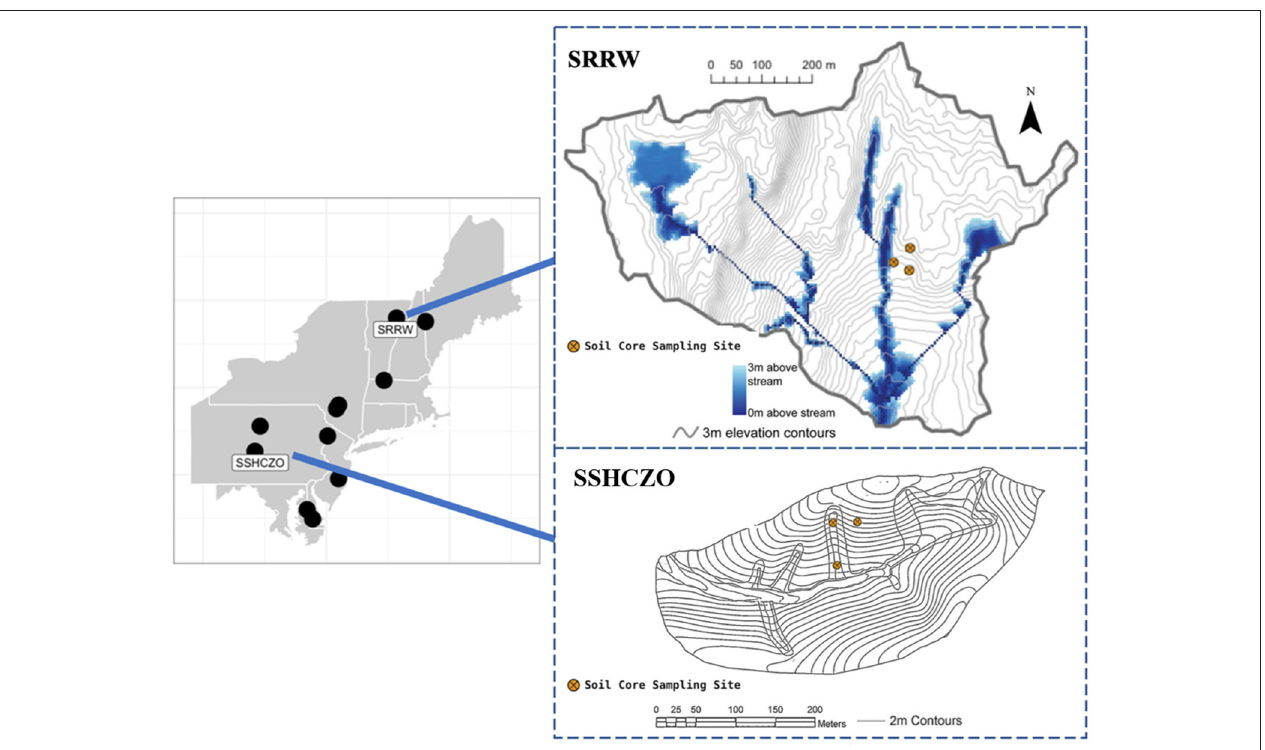
FIGURE 3 | Location of field sites: the Sleeper River Research Watershed (SRRW) map is derived from Shanley et al. (2015) and the Susquehanna Shale Hills Critical Zone Observatory (SSHCZO) map is modified after Lin et al. (2006) with permission. This figure was modified from Hydrological Processes, 29, Shanley, James B., Stephen D. Sebestyen, Jeffrey J. McDonnell, Brian L. McGlynn, and Thomas Dunne. ‘Water’s Way at Sleepers River watershed – revisiting flow generation in a post-glacial landscape, Vermont USA’, 3447–59, Copyright 2014, with permission from John Wiley and Sons and from Geoderma, 131, Soil moisture patterns in